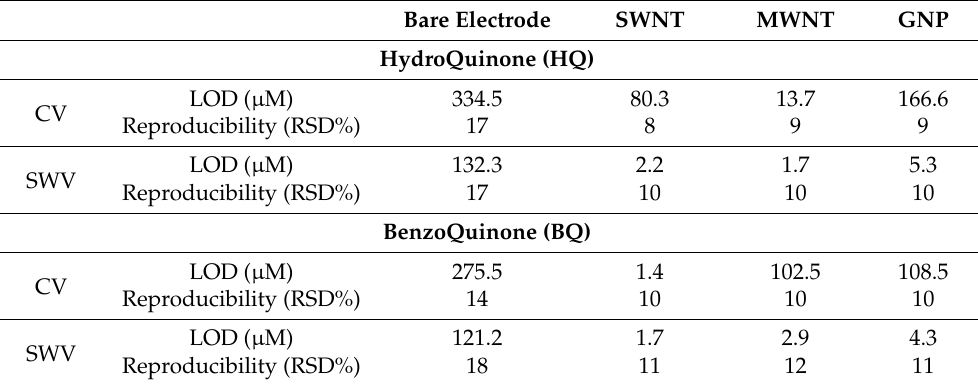
Table 3. Summary of the Limit of Detection and reproducibility obtained using CV and SWV in the analyses of several HQ and BQ-spiked water solutions. All analytical parameters are obtained from CV and SWV traces.